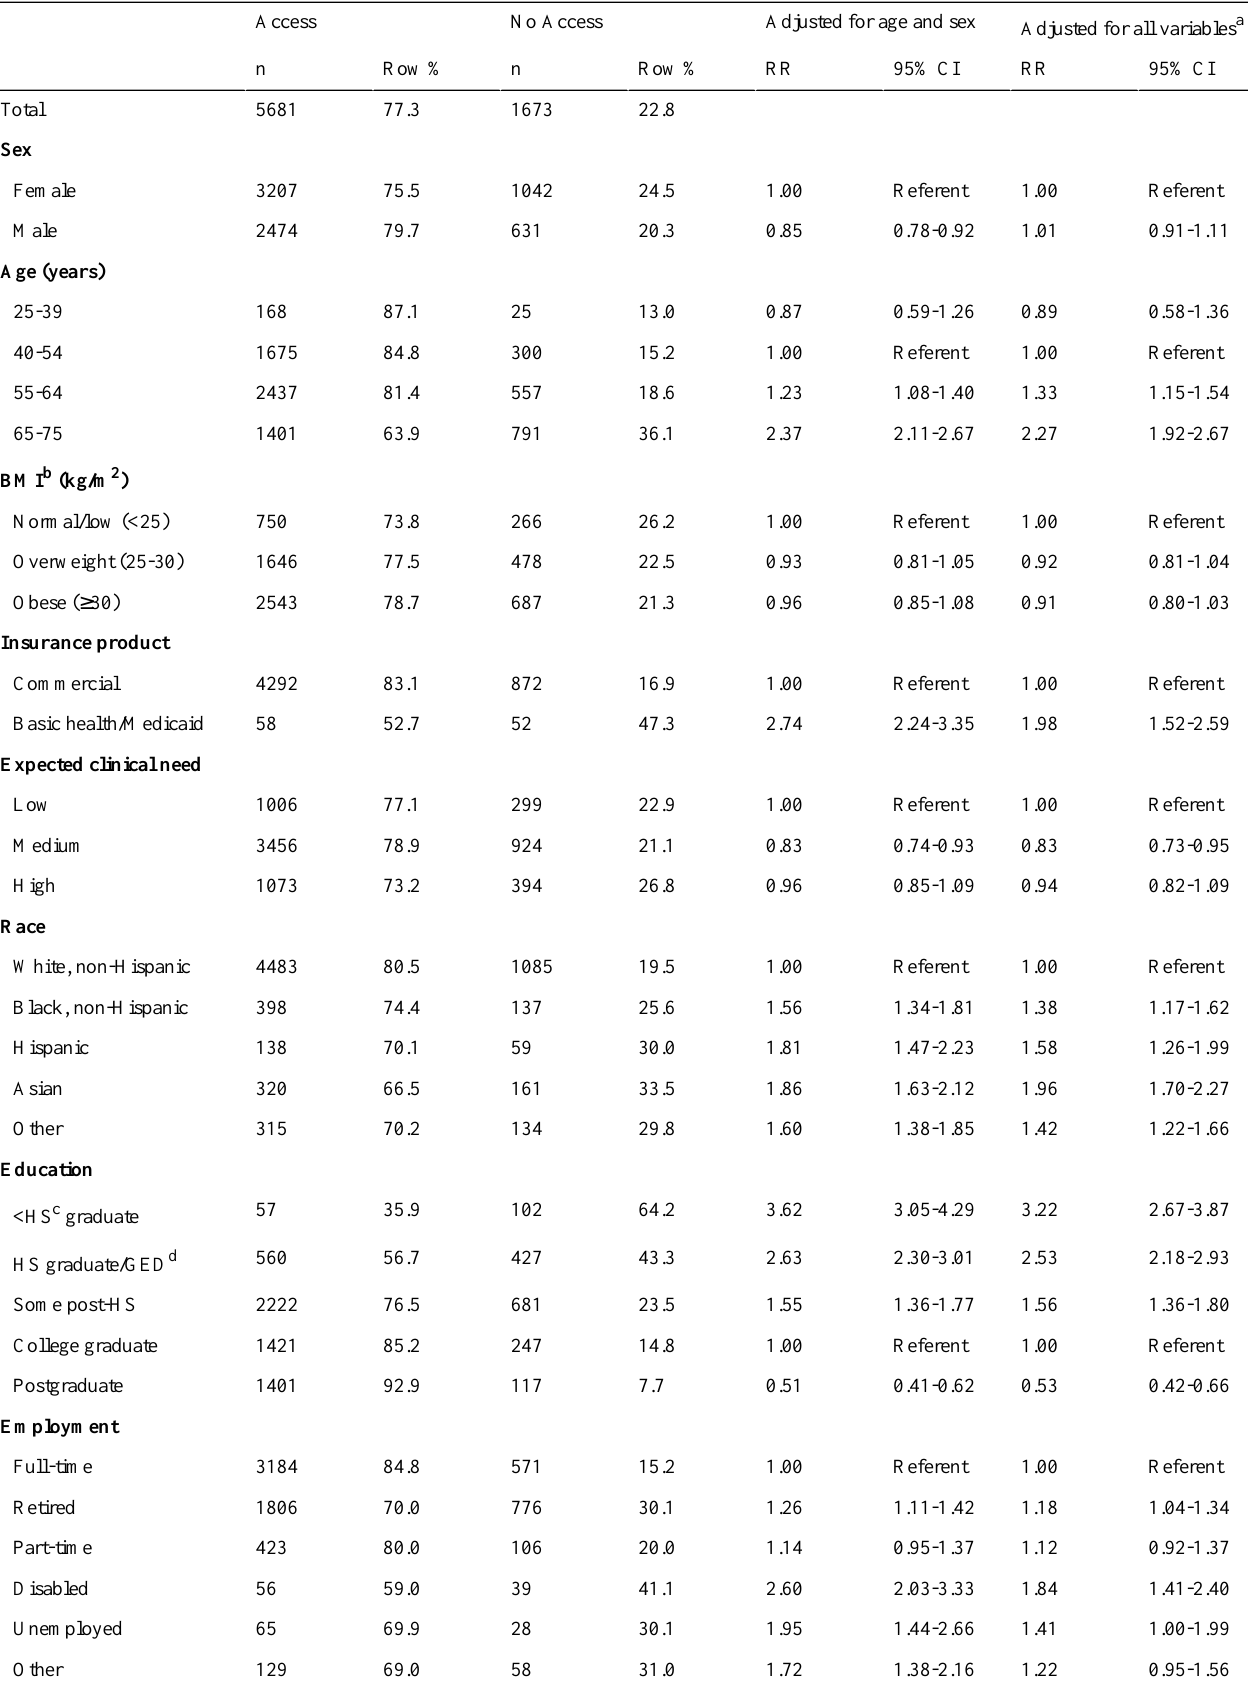
Table 2. Adjusted relative risk (RR) of not having computer access by demographic characteristics among patients for whom computer access was ascertained during the telephone screening survey (n = 7354)